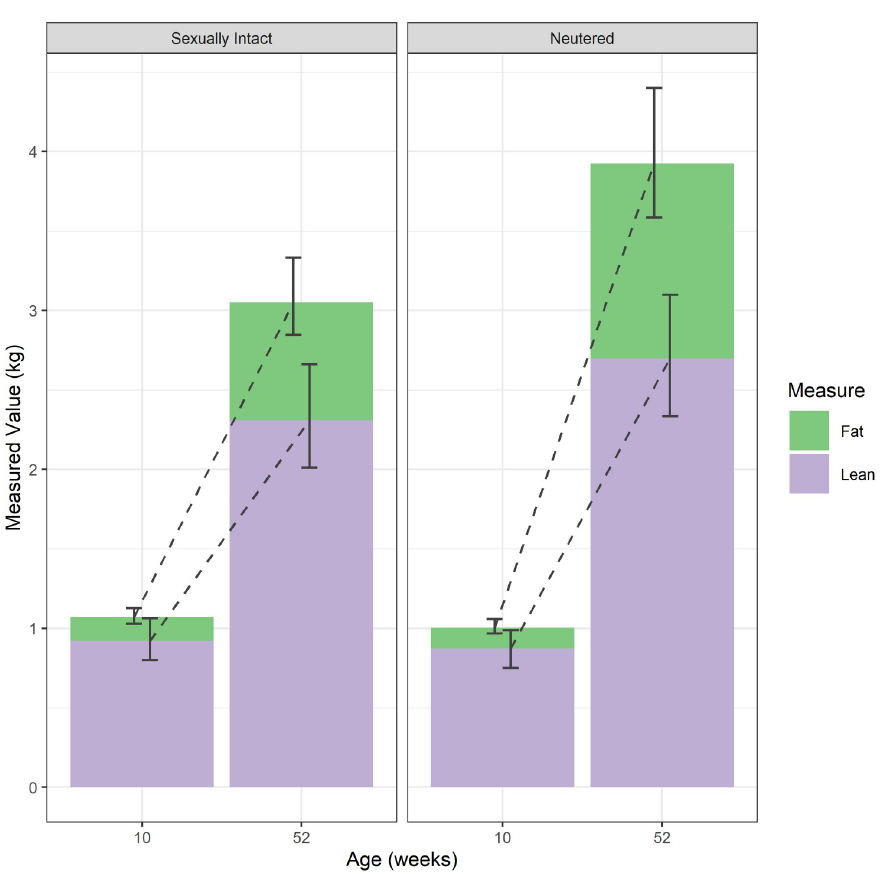
Fig 6. Estimated mean fat mass (green) and lean mass (lilac) at the initial and final measurement points for the sexually-intact and neutered kittens (11 cats per group). The intervals shown are simultaneous 95% credible intervals, whilst the green and lilac portions of each column represent fat and lean mass,